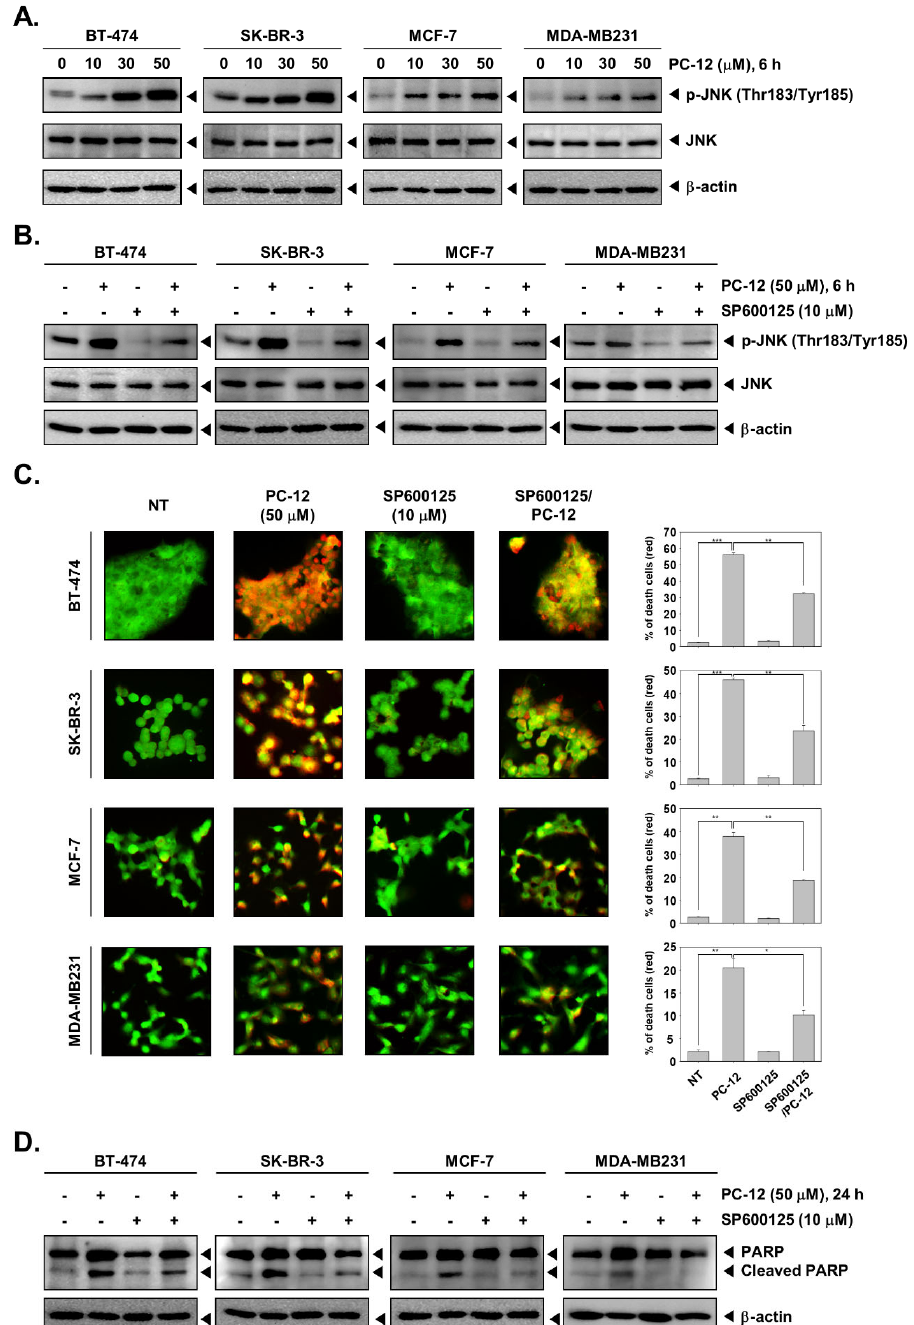
Figure 8. PC-12 induced PARP cleavage and cell death by activation of the JNK pathway. ( A ) The cells were treated with the indicated concentration of PC-12 for 6 h. The cells were harvested and lysed, and Western blot analysis was performed. β -ACTIN was used as input control. ( B ) The cells were treated with 0–50 µM of PC-12 or 10 µM of SP600125 for 6 h. After 6 h, the cells were collected, and Western blot analysis was performed. ( C ) The cells seeded in an 8-well chamber slide were treated with 50 µM of PC-12, 10 µM of SP600125, or a co-treatment of PC-12 (50 µM) and SP600125 (10 µM) for 24 h. After 24 h, cells were stained with calcein AM and EthD-1 for 30 min, and then live and dead cell assay was determined on a confocal microscope. *** p < 0.001, ** p < 0.01, and * p < 0.05 vs. PC-12-treated (NT) group. ( D ) The four cell lines were treated with the indicated concentrations of PC-12 or SP600125 for 24 h, and Western blot analysis was performed.